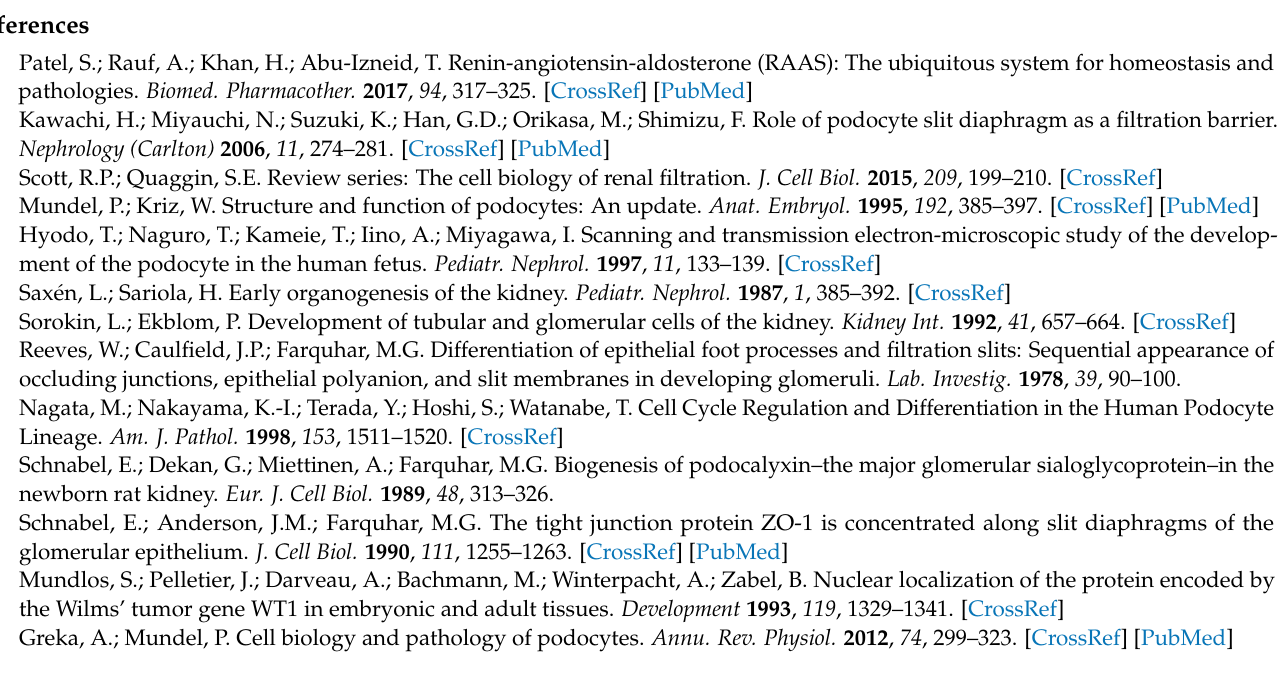
antibodies; Table S2: RT-qPCR Primers; Table S3: UM51 PrePodo vs UM51 PrePodo Htert Analysis Report; Table S4: UM51 Podo vs UM51 PrePodo Htert adv RPMI metascape